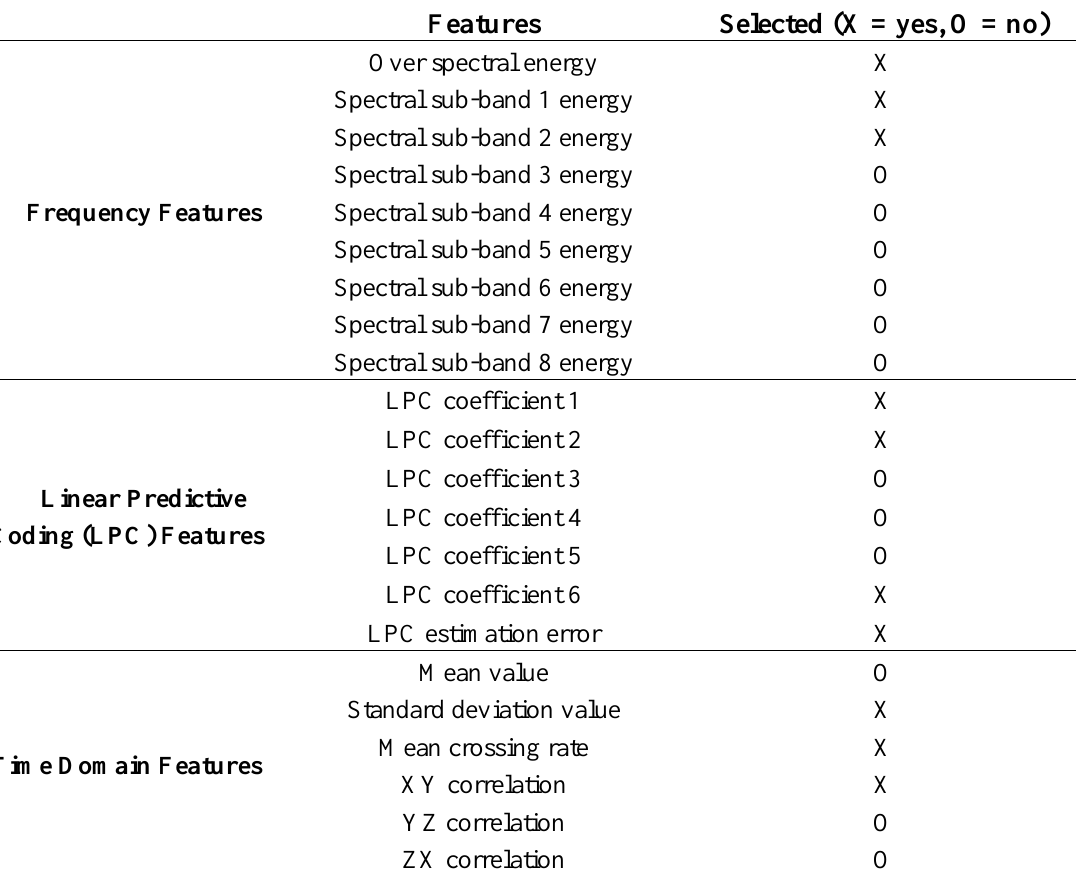
Table 2. Selected features from extracted by existing feature extraction methods.